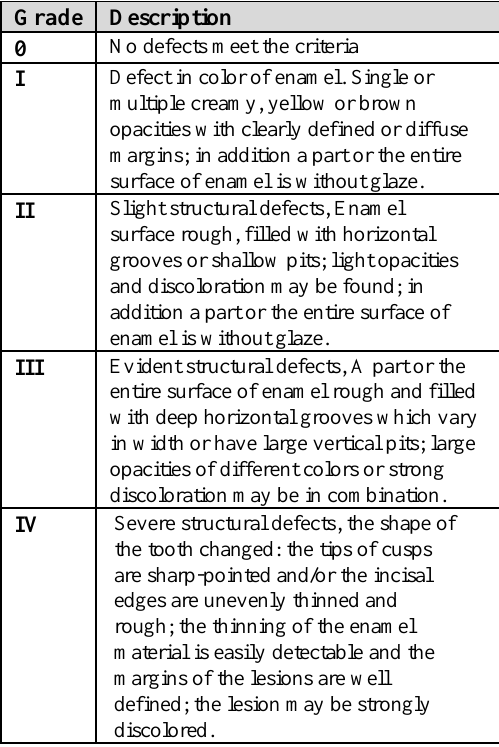
Table 1: Aine’s criteria for celiac disease specific dental enamel